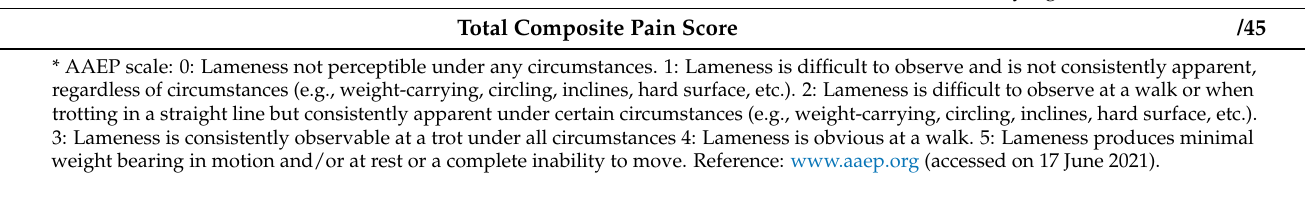
Table 3. Equine Utrecht University Scale for Facial Assessment of Pain (EQUUS-FAP). Assessments were based on a 2-minute observation period, as described in a previous study